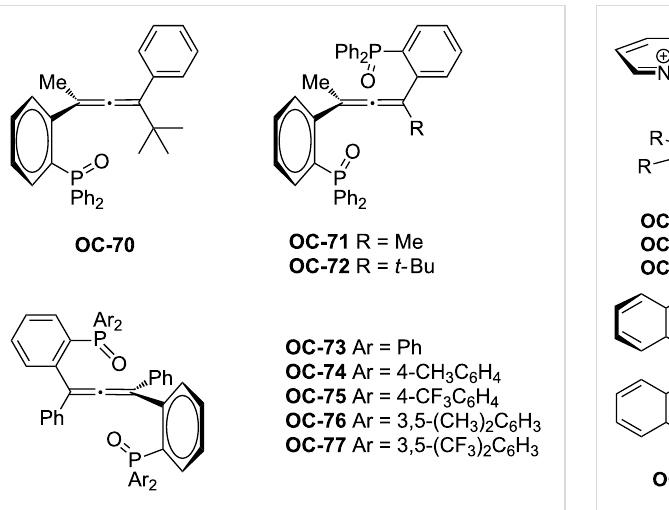
Figure 16: Chiral pyridine N -oxides used in enantioselective desym- metrization of meso